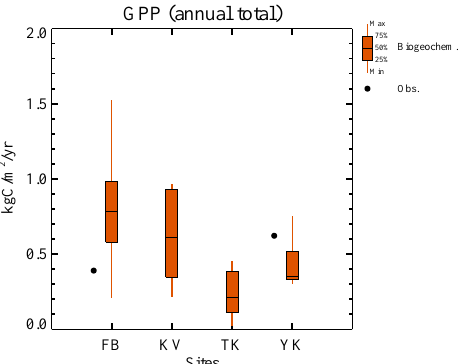
Figure 5. Example comparison of model outputs with observa- tions, and the inter-model range for the annual mean latent heat flux for averages from 1980 to 2013. The results of biogeochem- ical and physical models are shown by boxes and lines in orange and blue, respectively. The biogeochemical models included are BEAMS, Biome-BGC, CHANGE, SEIB-DGVM, and VISIT, while the physical models are 2LM, JULES, MATSIRO, and PB-SDM. The orange and blue horizontal lines indicate medians. The bottom and top of the boxes correspond to the 25th and 75th percentiles of the average values, for 1980–2013 (except BEMAS, which is for 2001–2011), of model outputs. The bottom and top of the lines show the minimum and maximum outputs from the participating models, respectively. The dots show the observed average values for 2011, 2012, and 2013 at FB and for 1998, 2001, 2003, 2004, 2007, and 2008 at YK.